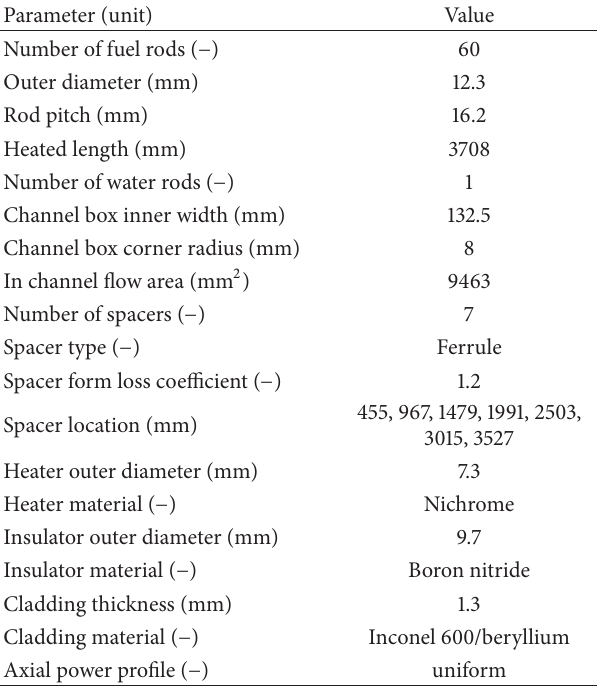
Table 1: Main features of assembly type